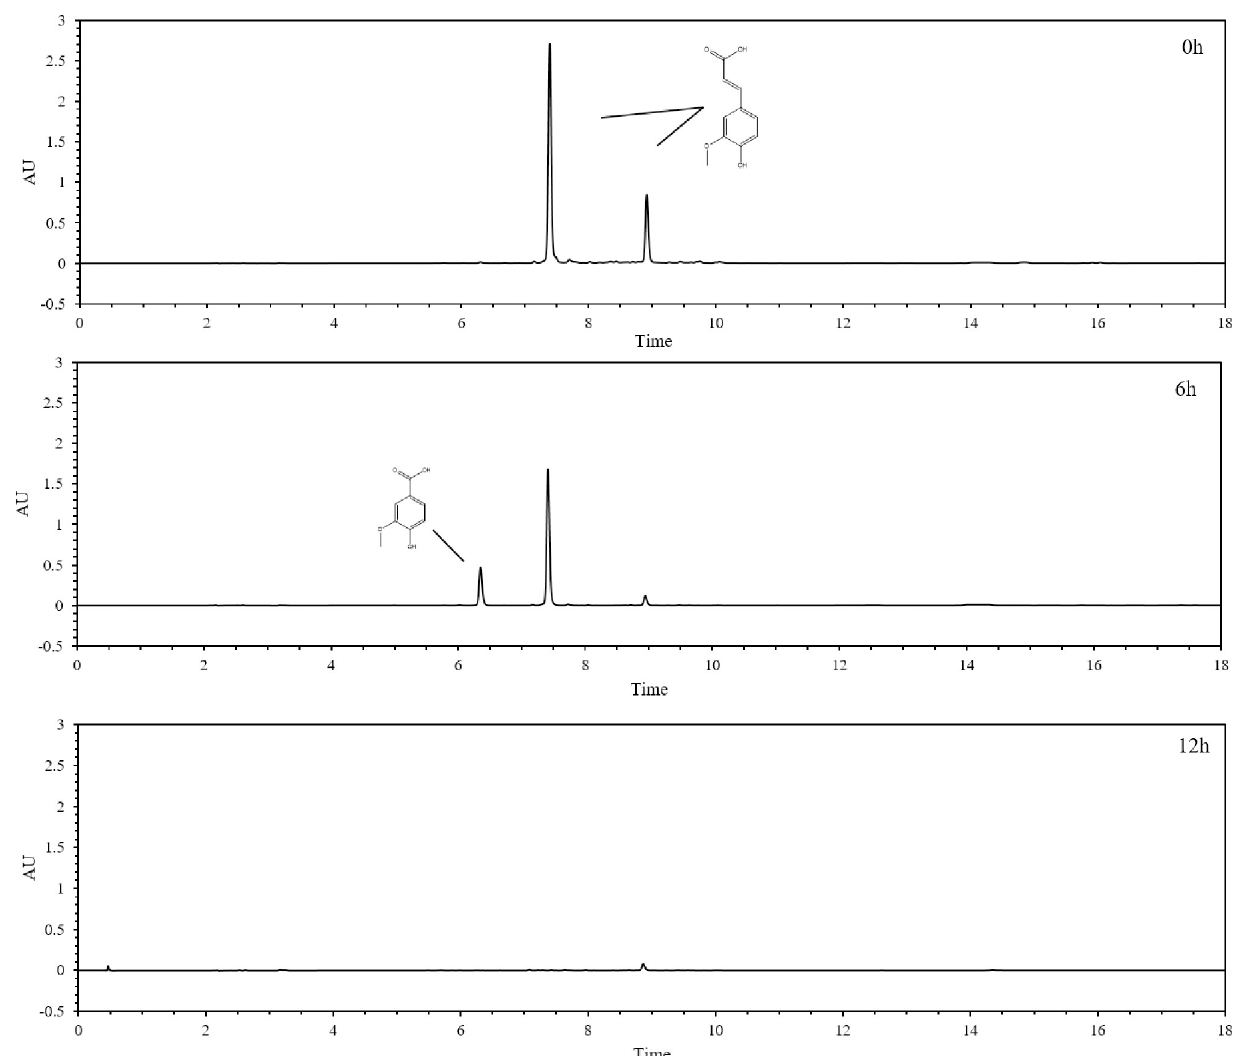
Fig 5. The formation of the intermediates in the biodegradation of ferulic acid in ZXY12VA01 shown in the HPLC analysis. The major metabolites were detected on the 0h (A), 12h (B) and 24h (C),